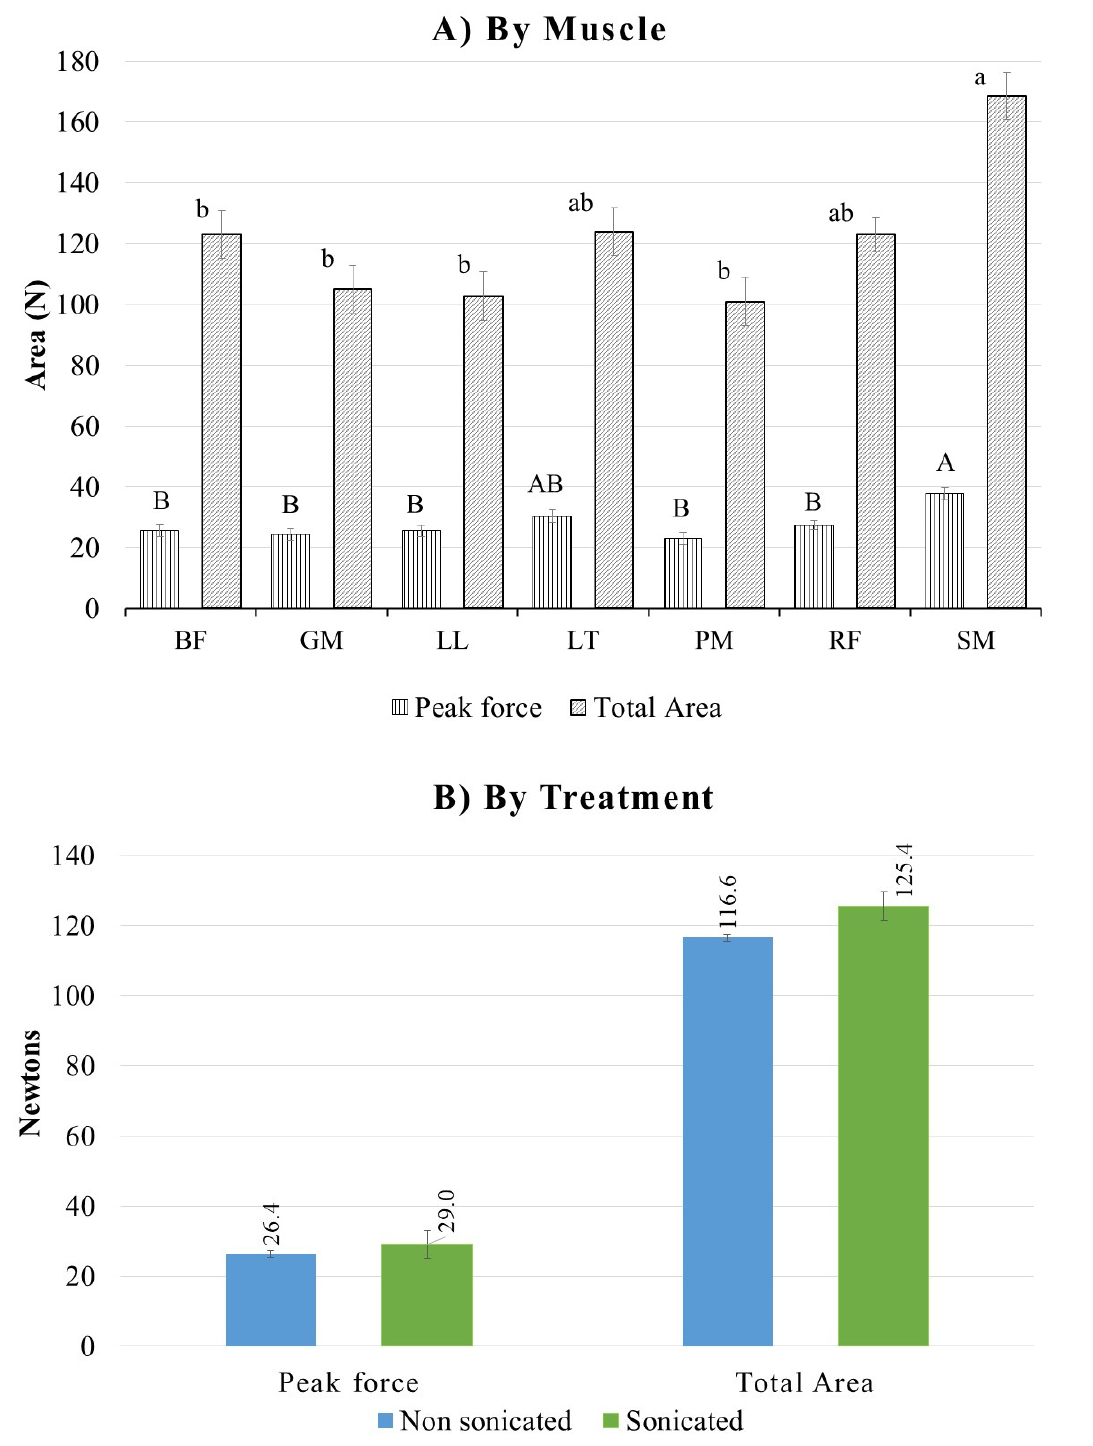
Figure 2. Shear force properties (total area and peak shear force) of 23-day-aged beef after simulated retail display (75% O 2 : 25% CO 2 , 3 ◦ C) for 5 d. ( A ) corresponds to values by muscle: BF = Biceps femoris . GM = Gluteus medius . LL = Longissimus lumborum . LT = Longissimus thoracis . PM = Psoas major . RF = Rectus femoris . Different letters represent significant differences ( p < 0.05) among muscles into the same parameter (Lowercase letters for area and capital letters for peak force). SM = Semitendinosus . ( B ) corresponds to values by treatment: Sonicated meat at 28 W/cm 2 after ageing. The shear force values observed in the meat of this study because of the ageing process were extremely low (26.7 to 28.7 N). These Warner–Bratzler shear forces correspond to very tender beef